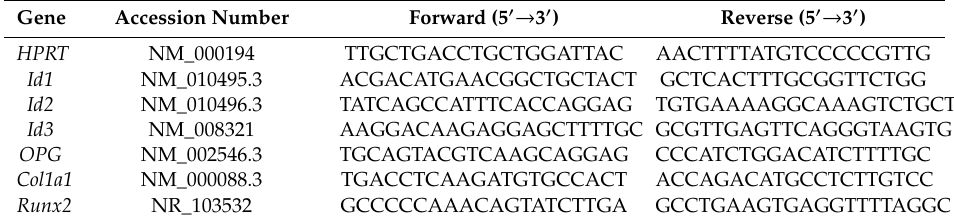
Table 2. Murine primers for quantitative real-time polymerase chain reaction